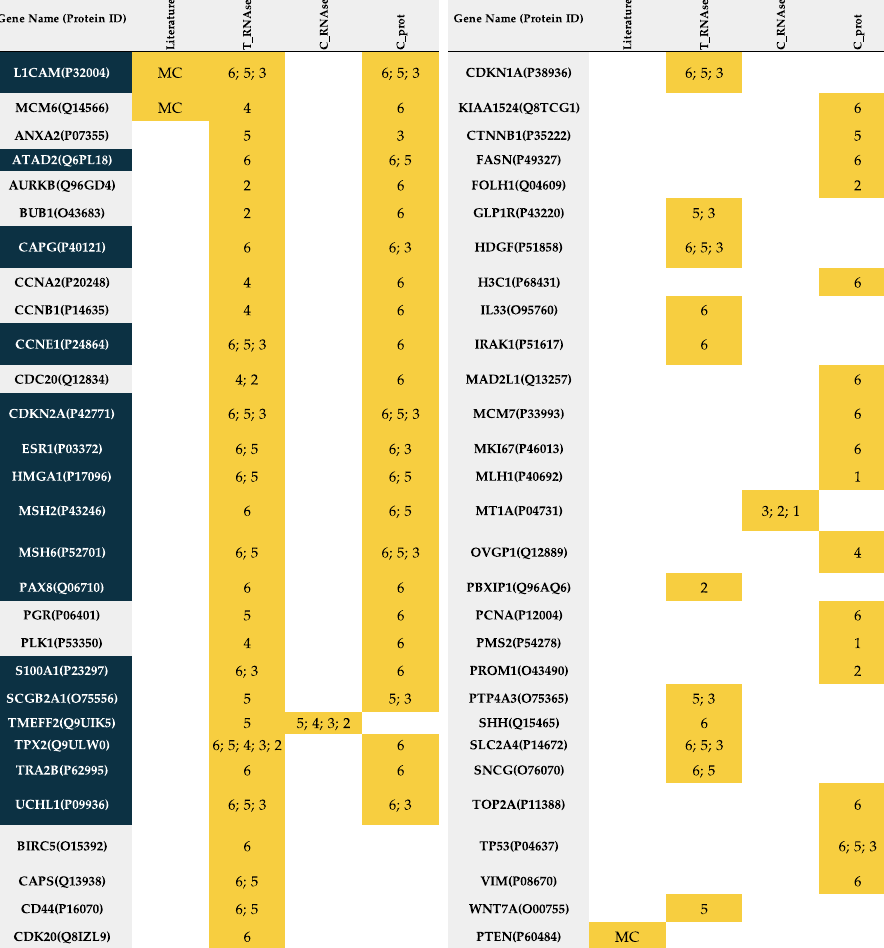
Figure 4. Biomarkers related to the molecular classification. Table of genes/proteins that were found differentially expressed between any of the molecular subgroups in any of the tested cohorts (in grey). Highlighted in yellow, the specific cohort in which each protein was found to be differentially expressed between subgroups and indicated the specific comparison. The numbers indicate the specific comparison where each biomarker was found differential. Proteins highlighted in blue are those validated in more than one cohort. MC: Molecular classification defined by The Cancer Genome Atlas Network;